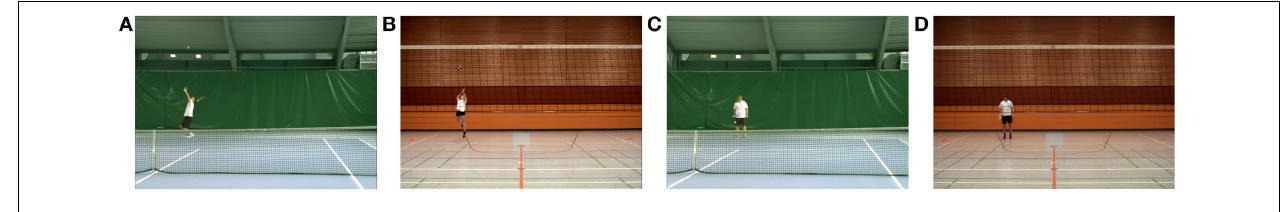
FIGURE 1 | Screenshots of all four experimental conditions. Each of the 128 video clips lasted 2.9–4.6s. (A) Male tennis player performing a tennis serve ( Tennis Anticipation condition). (B) Female volleyball player performing a volleyball serve ( Volleyball Anticipation condition). All serve sequences